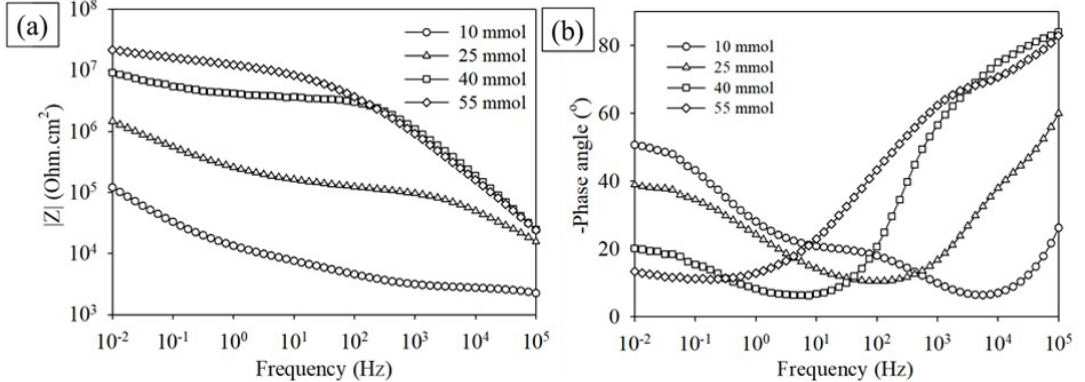
Figure 7. Bode plots for (a) impedance and (b) phase angle for superhydrophobic coatings deposited onto carbon steel considering different amounts of precursors in the hydrolysis solution, after 5 hours of immersion in NaCl